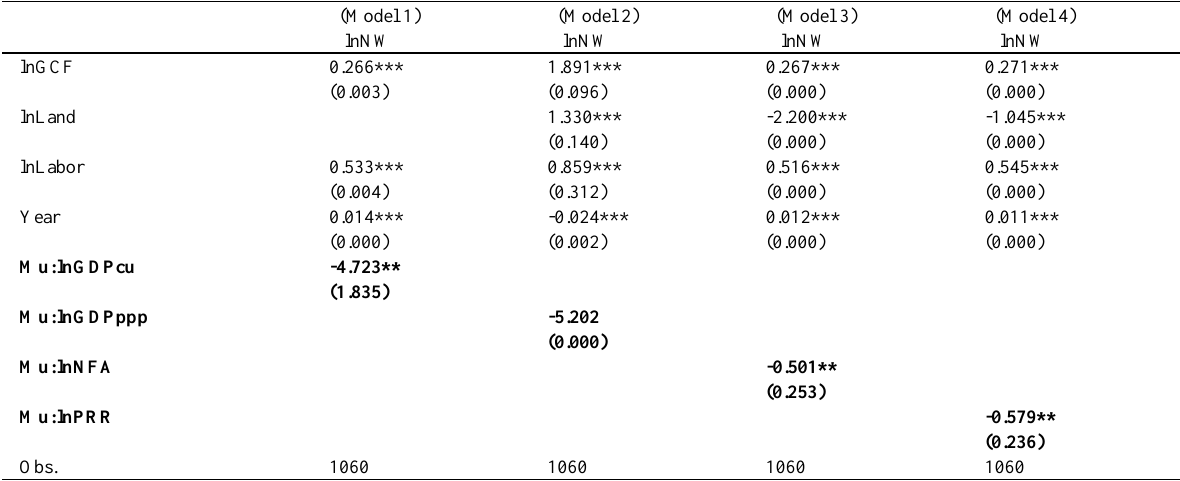
Table 5: Stochastic Frontier Analysis results for four different models with different